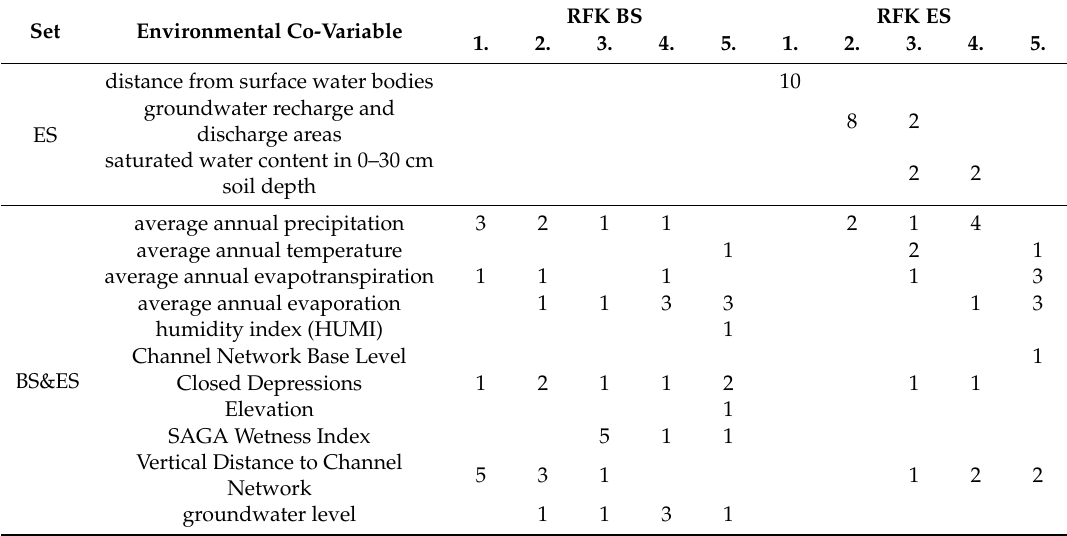
Table 1. Occurrences of environmental co-variables in variable importance rank (position 1–5) of Random Forest (RF) in the Random Forest combined with Ordinary Kriging (RFK) models (BS: basic set, ES: extended set of